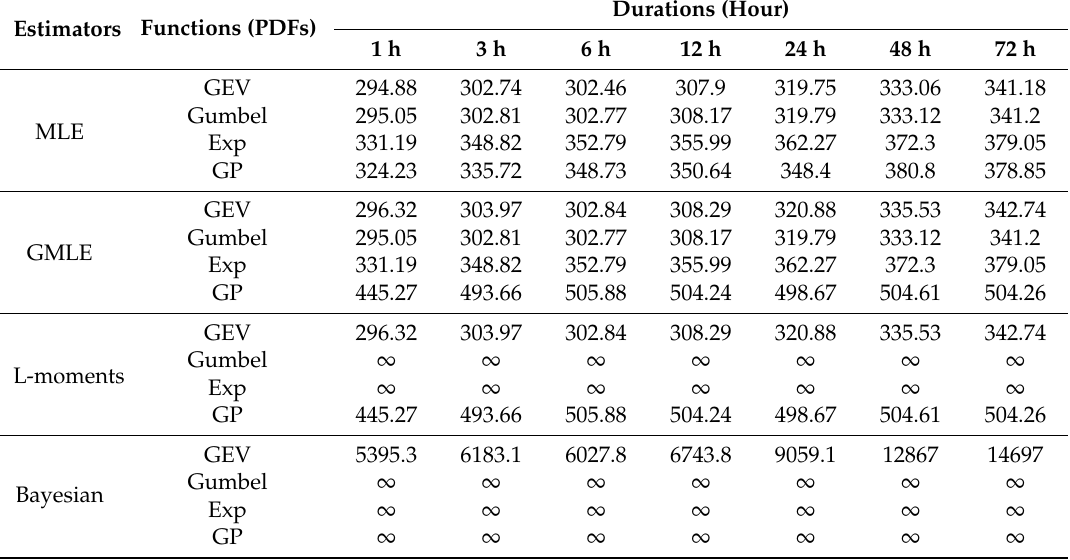
Table 3. The results of goodness-of-fit test at a station located in Kedah.